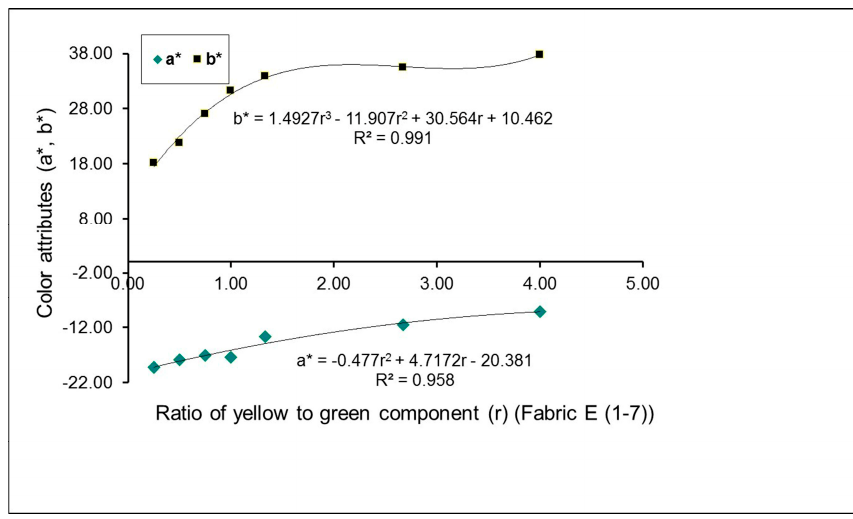
Figure 4. Effect of the proportion of green-yellow weft yarns on mixed color attributes ( a * and b *) of fabrics without a regulating layer.